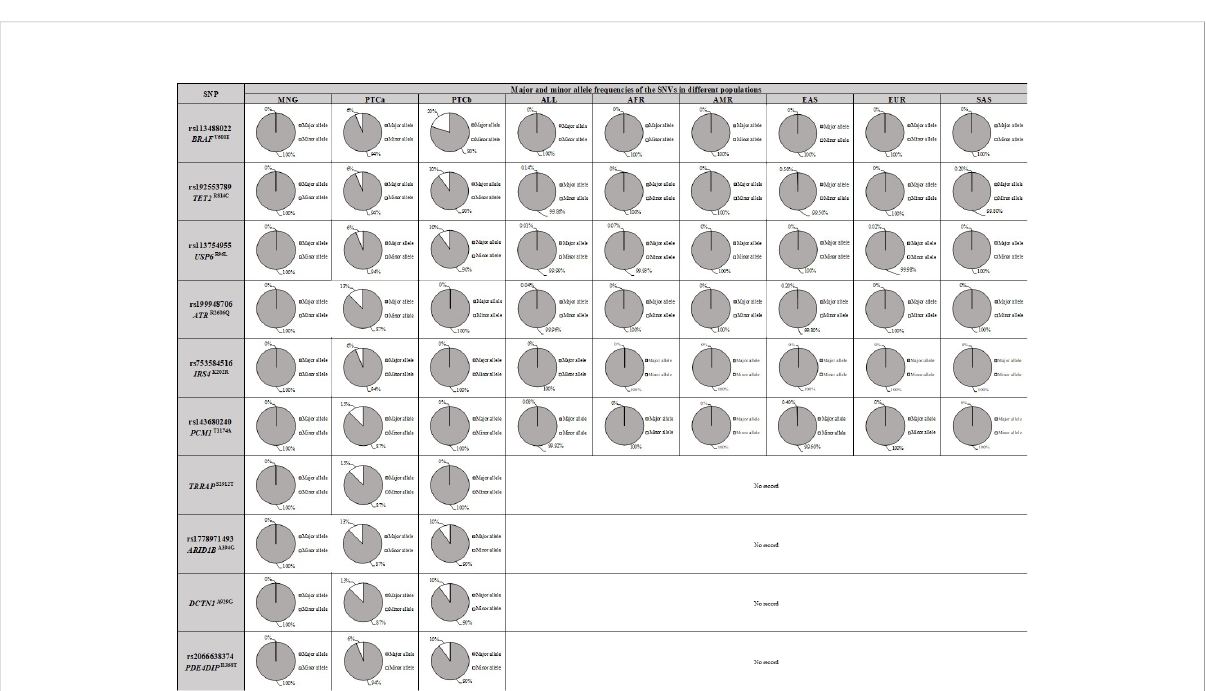
FIGURE 5 Comparison of allelic frequencies of ten PTC-speci fi c SNPs in BTG, PTCa, PTCb and various populations. The data of different populations were obtained from Ensembl population genetic database (https://asia.ensembl.org/index.html). ALL, all populations; AFR, African; AMR, American; EAS, East Asian; EUR, European; SAS, South Asian. Major allele refers to the wildtype allele; minor allele refers to the mutant allele. BTG, Benign thyroid goitre; PTCa, Papillary thyroid cancer without BTG background; PTCb, Papillary thyroid cancer with BTG background.